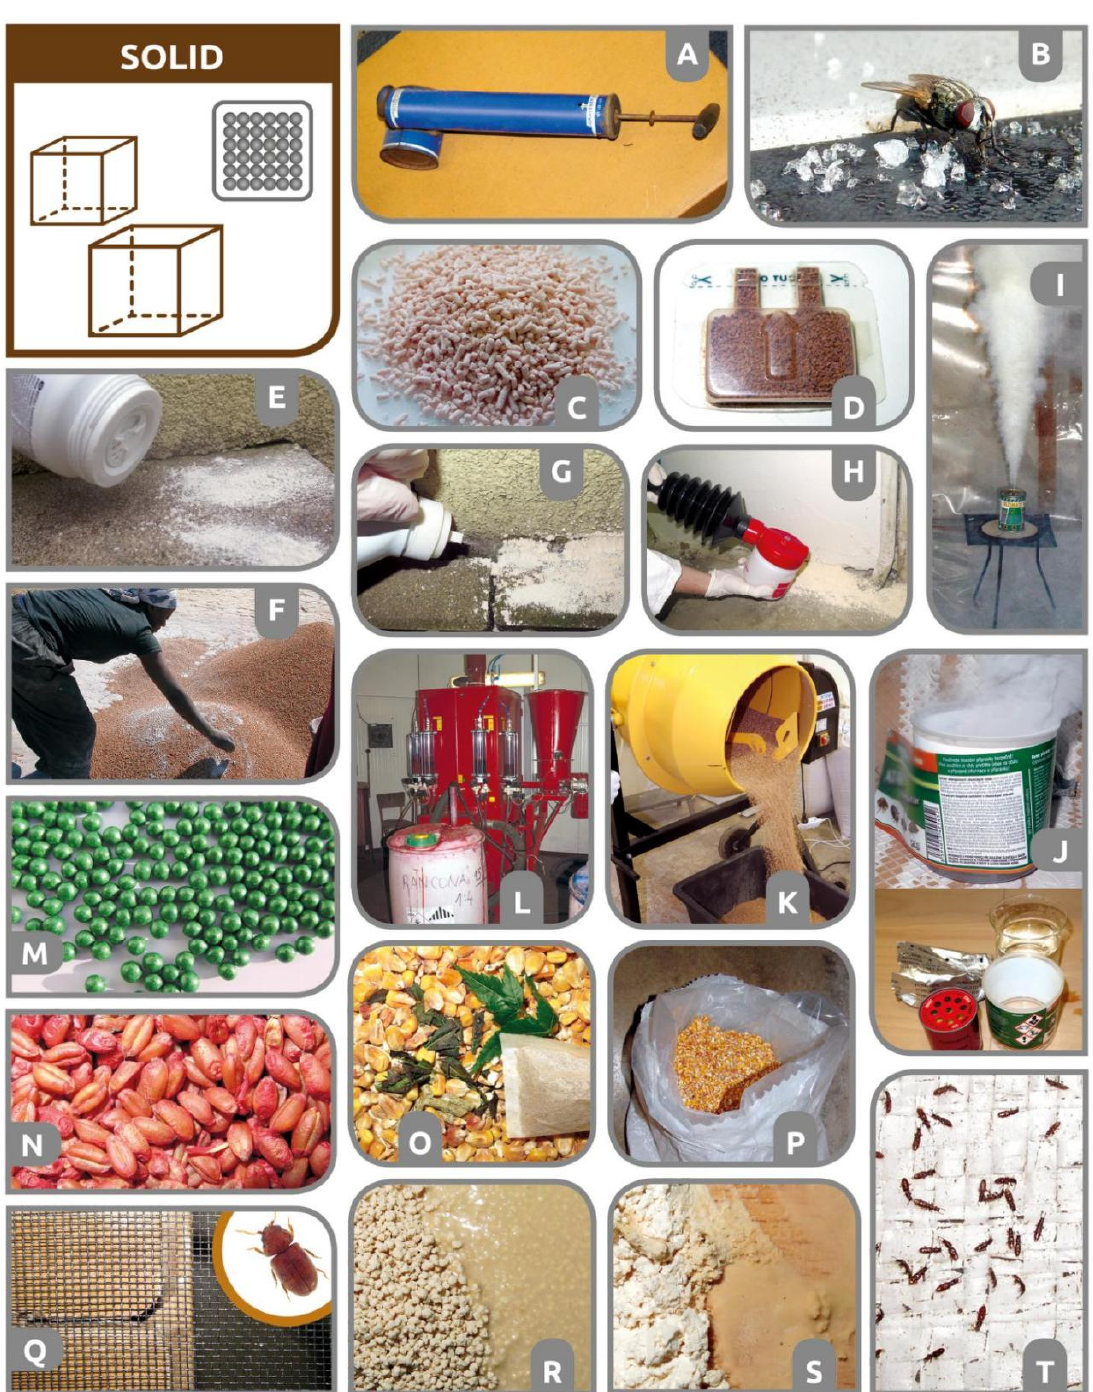
Figure 5. Solids. ( A ) Historical hand-pumped piston-gun: it was modified either for the application of aerosols (“Flit-gun”/“Fly-tox”) or as a sprayer or duster for the application of insecticide deposits; ( B ) application of baits in solid crystalloid form (sugar); ( C ) pelleted baits in bulk formulation; ( D ) granular baits enclosed in protective boxes; ( E ) duster container with a perforated lid applicator; ( F ) manual application of botanical ash/dust by low-income rural farmers; ( G ) duster container with an injection lid applicator; ( H ) visualization of barrier dusting; ( I ) ignition-activated smoke genera- tor; ( J ) water-activated (chemically activated) smoke generator; ( K ) dust admixed with grain with the help of motorized or manually rotated drums; ( L ) seed treatment (dressing/coating and coloring with a warning dye); ( M , N ) various forms of dressed, coated, and colored seeds; ( O ) visualization of an admixture of grain kernels with solid traditional (fresh or dried parts of plants, e.g., neem) and new (tablets, granules, sachets) formulations of botanical insecticides; ( P ) visualiza- tion of a triple-layer hermetic bag with incorporated insecticide; ( Q ) visualization of a pest control net with incorporated